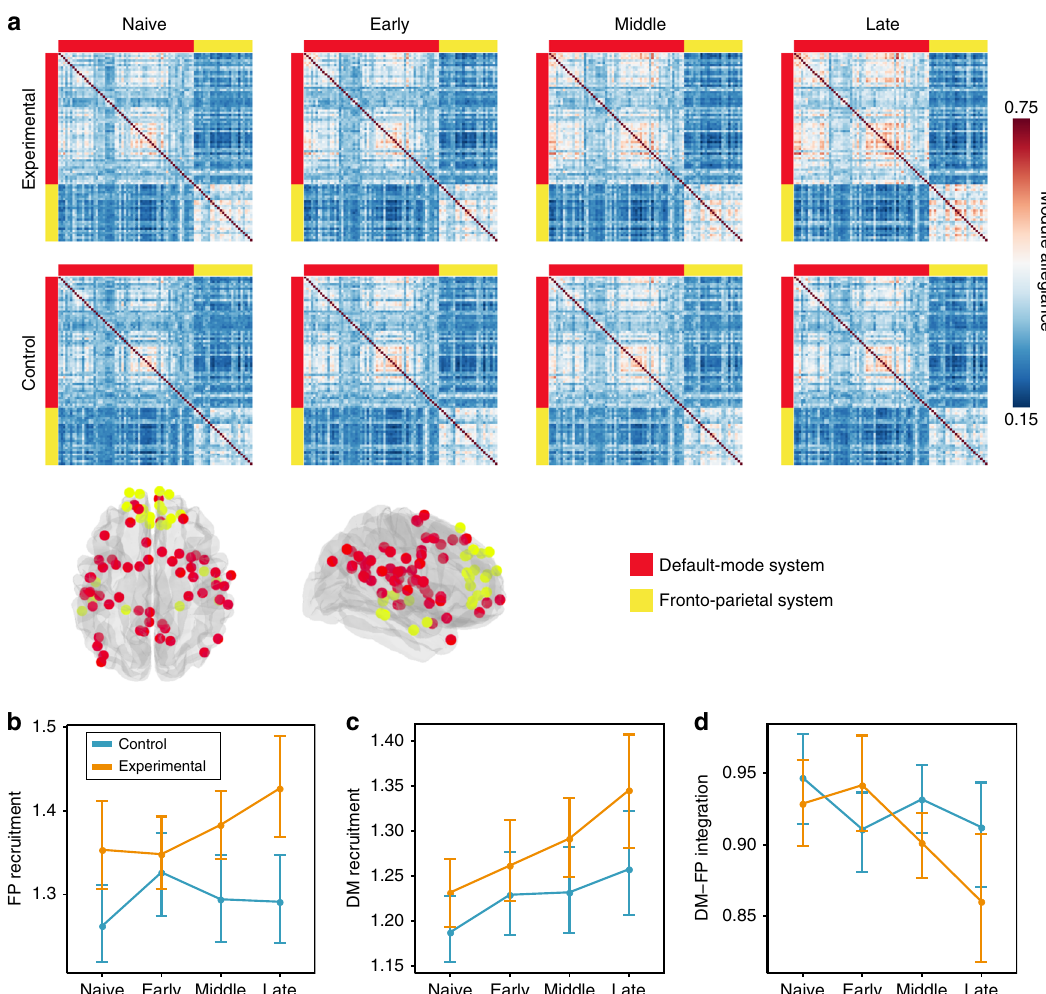
Fig. 5 Changes in module allegiance of the frontoparietal (FP) and default-mode (DM) systems. a Module allegiance matrices for the default-mode and frontoparietal systems. Each ij th element of the matrix represents the probability that node i and node j are assigned to the same module within a single layer of the multilayer network. b Only the experimental ( n = 21) group exhibited increases in frontoparietal recruitment across sessions. c Both experimental and control groups ( n = 21) exhibited increases in default mode recruitment between “ Naive ” and “ Late ” stages of training. d In both groups, the integration between the frontoparietal and default-mode systems decreased from “ Naive ” to “ Late ” sessions, but groups differed in the pattern of integration changes between “ Naive ” to “ Middle ” sessions (see also Supplementary Fig. 6). We observed a similar pattern of changes when considering allegiance matrices calculated based on signed functional connectivity matrices (Supplementary Fig. 14) and alternative brain parcellation 58 (Supplementary Fig. 17). Dots represent mean values; error bars represent 95% con fi dence intervals. Source data are provided as a Source Data fi